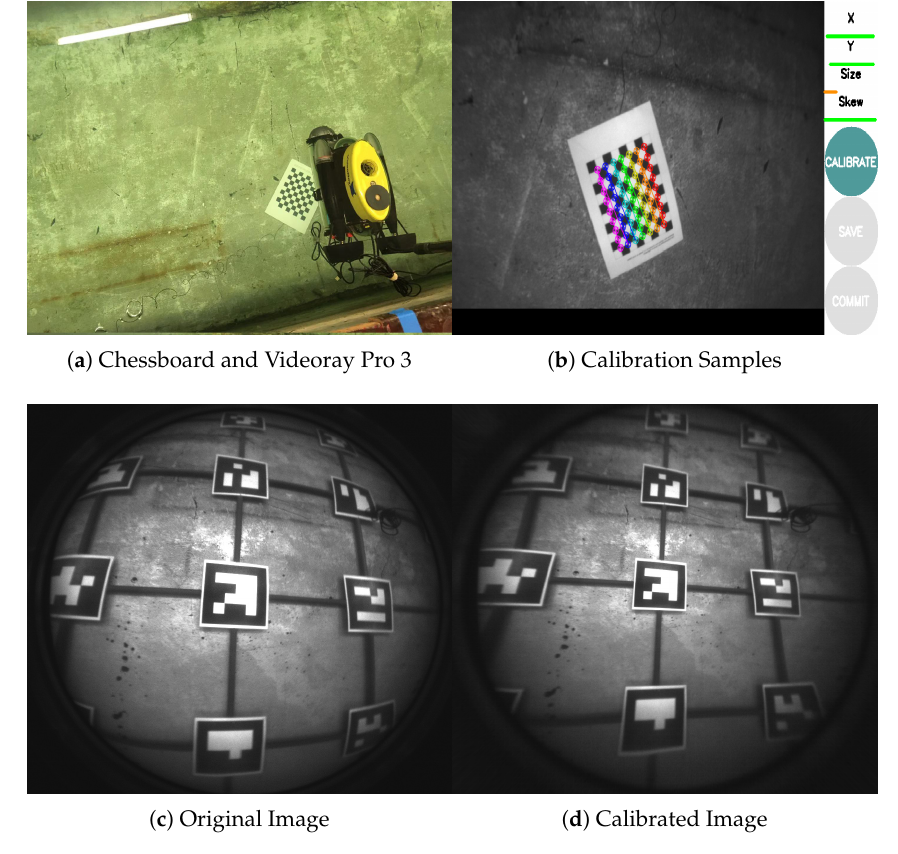
Figure 3. ( a ) The chessboard on the ground and the vehicle are operated to capture the images. ( b ) The calibration is processed based on the captured patterns. ( c ) The original image. ( d ) The same image after being calibrated.